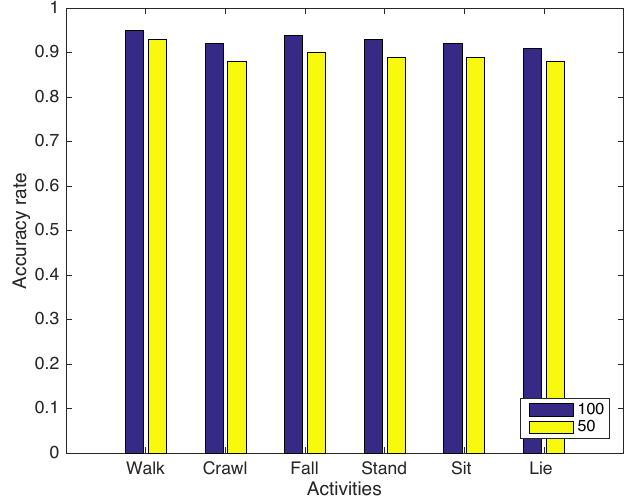
Figure 9. Classification accuracy results with 100 and 50 training